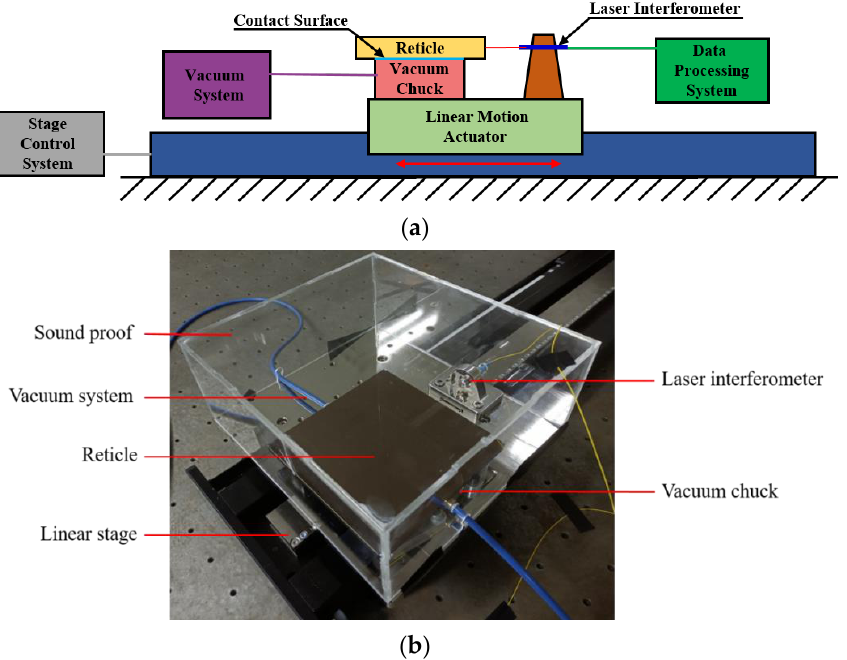
Figure 8. Dynamic friction sliding measurement system: ( a ) schematic of dynamic friction sliding measurement system; ( b ) dynamic friction sliding measurement experiment.